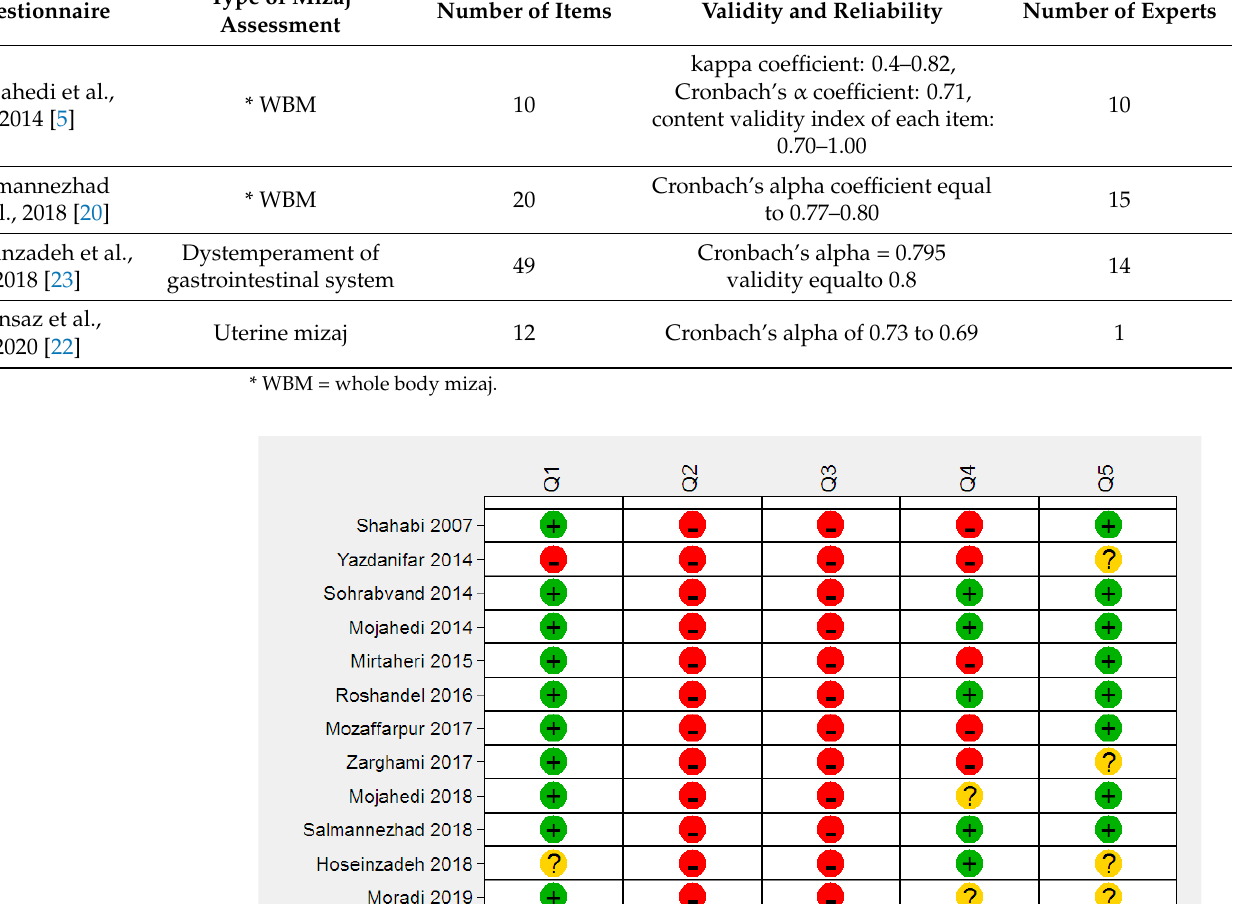
Table 2. Details of articles with questionnaires.